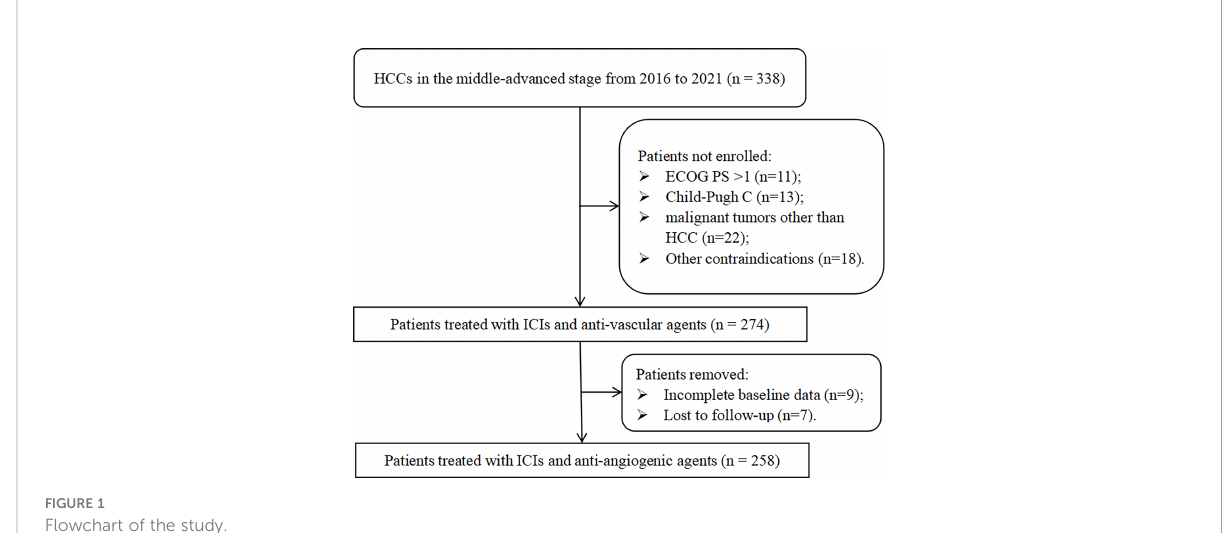
FIGURE 1 Flowchart of the